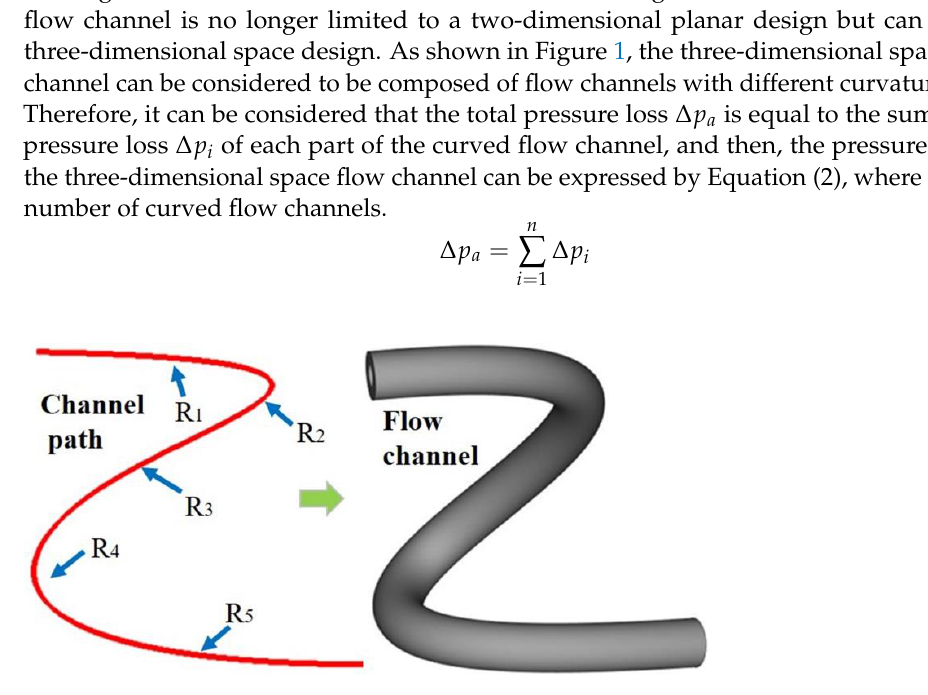
Figure 1. Three-dimensional space flow channel composed of different curvature